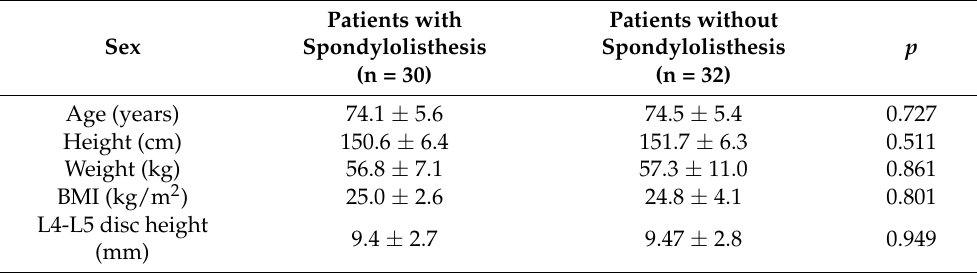
Table 1. Demographic and radiological characteristics of patients.